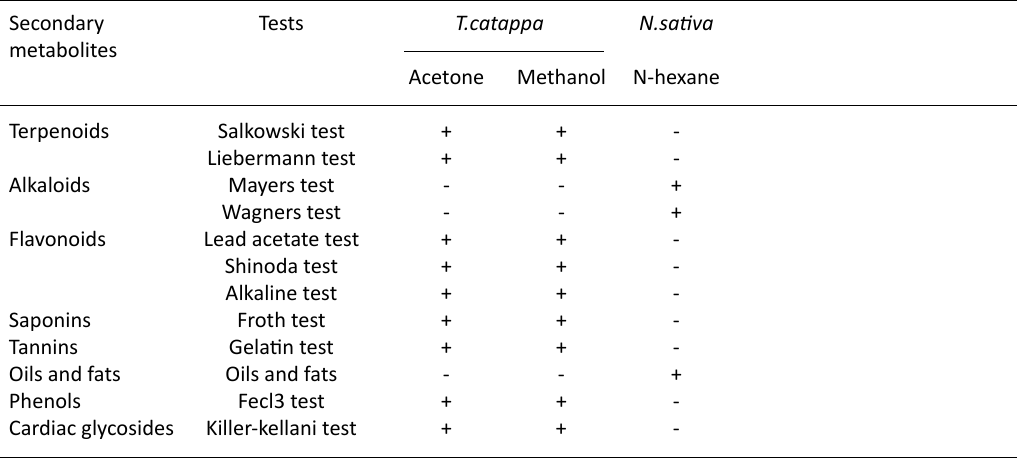
Table 3. Qualitative phytochemical analysis of the test plants